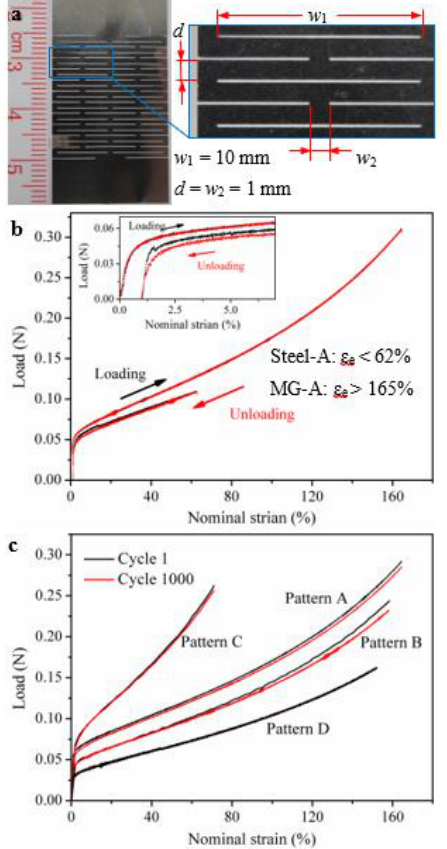
Figure 8. ( a ) The optical image of a kirigami MG structure. ( b ) The load-nominal strain curves of a kirigami MG structures, showing an elastic strain larger than 165%. For comparison, a stainless steel kirigami structure has an elastic limit smaller than 62%. ( c ) The elastic strain energy loss of the kirigami MG structures after 1000 cycles of loadings with four different kirigami patterns. Adapted from [19] with copyright permission from Elsevier, 2018.